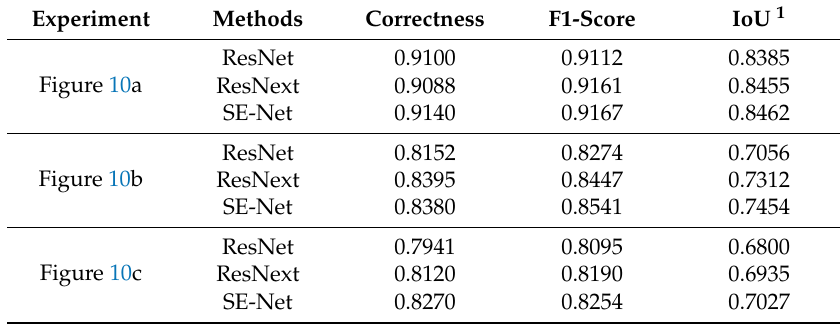
Table 3. Quantitative comparison of three backbone networks for the testing dataset.